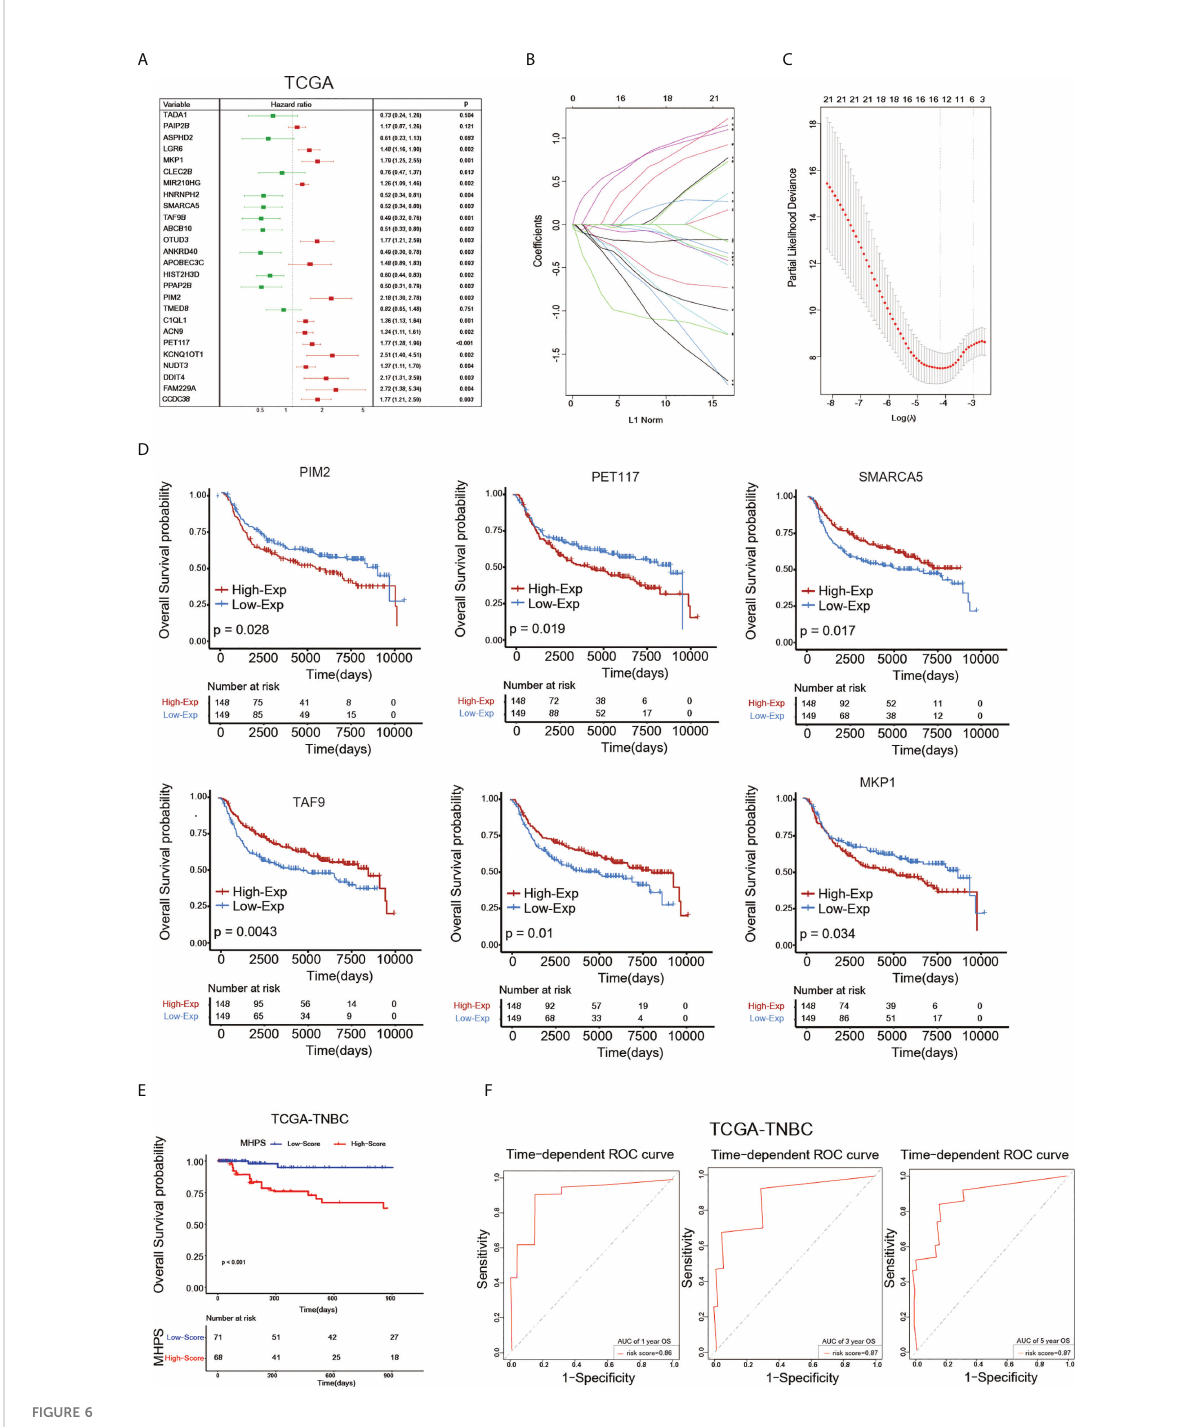
FIGURE 6 Construction of m6A-hypoxia signature(MHPS). (A) The Forest plot of Univariate Cox regression analysis of 26 m6A-hypoxia genes. (B, C) LASSO-Cox regression analysis and partial likelihood deviance of prognostic m6A-hypoxia genes. (D) The K-M analysis of 6 candidates gene consisting of signature. (E) The K-M analysis of overall survival (OS) between the high- and low-risk groups in TCGA-TNBC. (F) ROC curve analysis of MHPS in TNBC